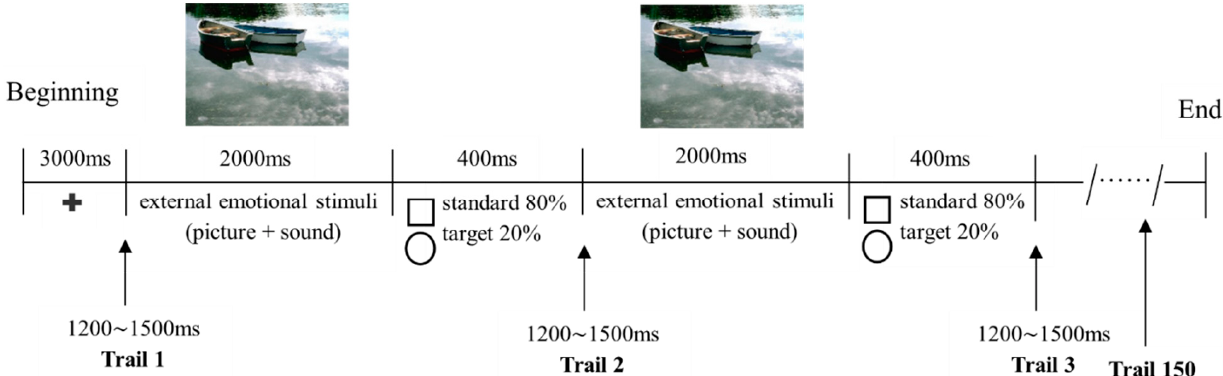
Figure 1. Timeline of events in the oddball paradigm. Participants were instructed to respond to a circle picture (target stimulus) as quickly as possible by pressing a button with their right index finger, and to do nothing to the square picture (standard stimulus) or emotional scenes (taking Neutral as an example). Note: + , fixation cross representing the beginning of the paradigm.